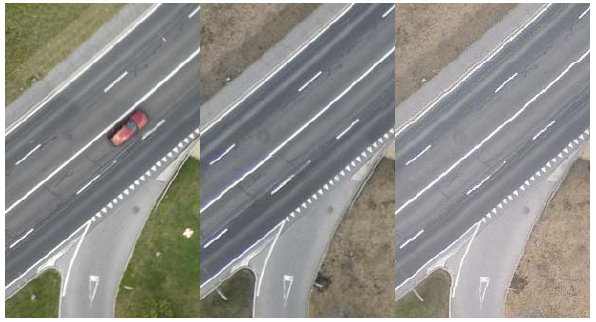
Figure 9: Aspect of orthoimage. Left: reference, Middle: SocetSet, Right: